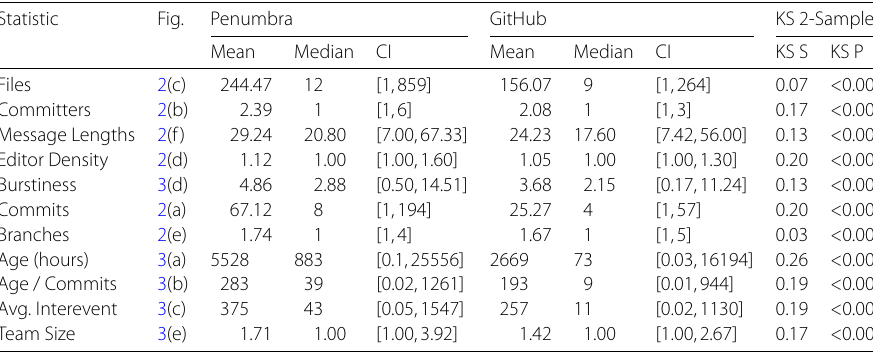
Table 2 Comparison of Penumbra and GitHub datasets